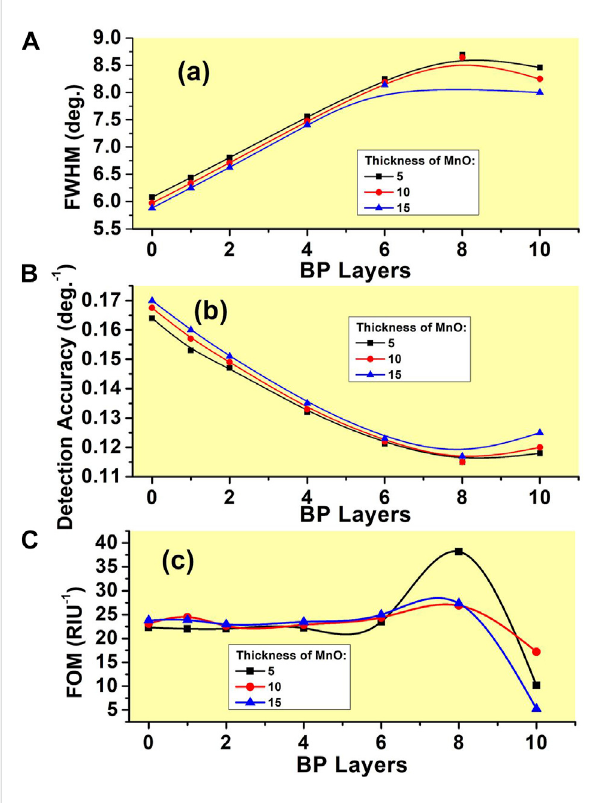
FIGURE 9 Variation of (A) FWHM (B) Detection accuracy (DA) (C) The fi gure of merit (FOM) with the increment of the number of layers of